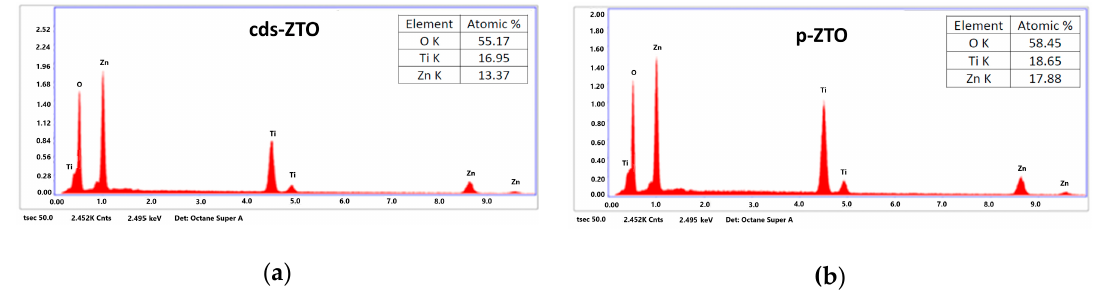
Figure 4. EDS of ZTO materials synthesized: ( a ) cds-ZTO sample and ( b ) p-ZTO sample.